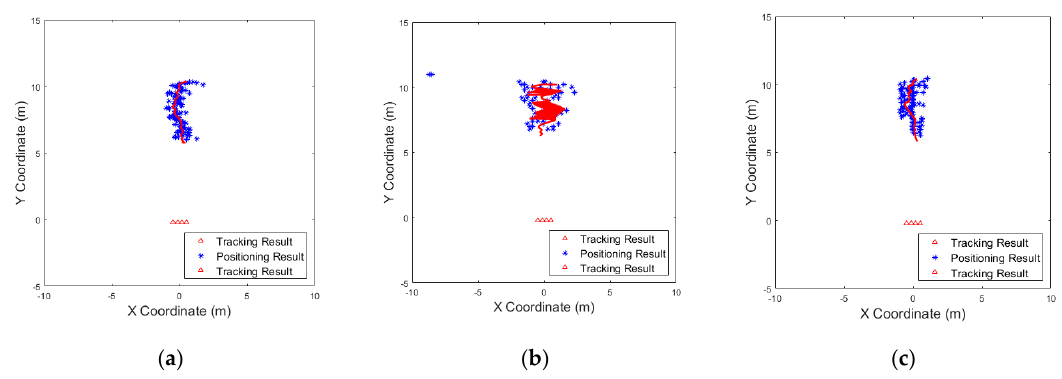
Figure 7. Example of tracking performances for different positioning methods: ( a ) trilateration; ( b ) delay-and-sum; ( c ) proposed algorithm.